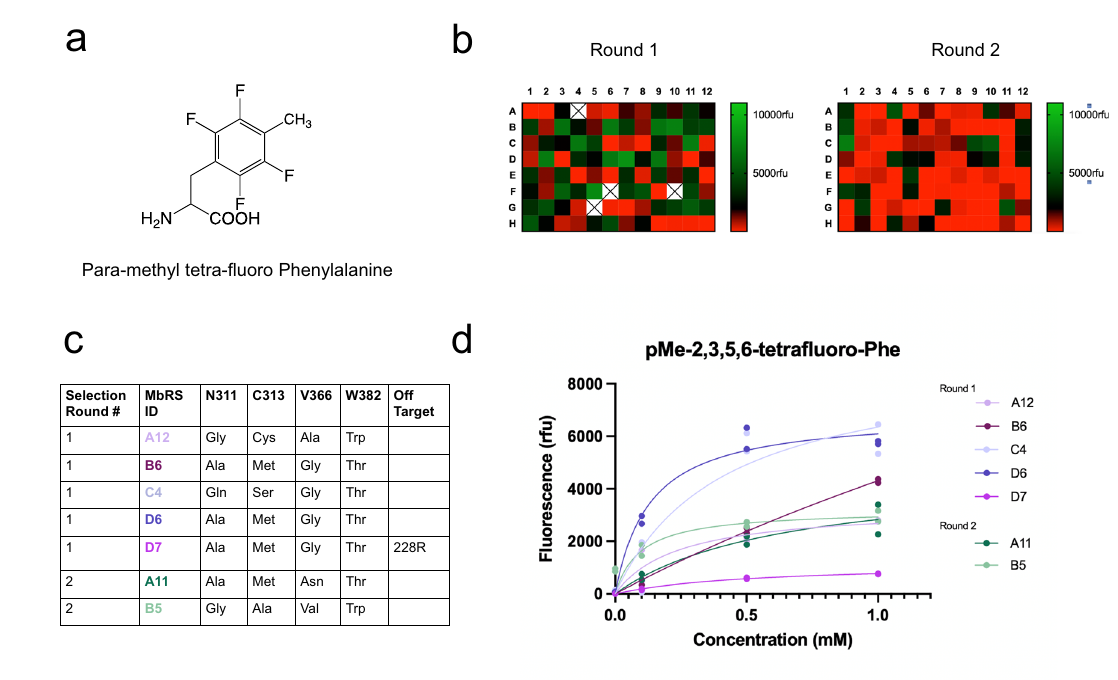
Fig. 2 | Strategy and identi fi cation of synthetases. a Chemical structure of para- methyl, tetra- fl uoro Phe, which was used for screening in a PylRs library in E. coli . b HeatmapsofsynthetaseshitsandrelativeGFPN150TAGrescuewithpara-methyl, tetra- fl uoroPhe.Rounds1and2wereindependentscreensofthelibrarywithpara-